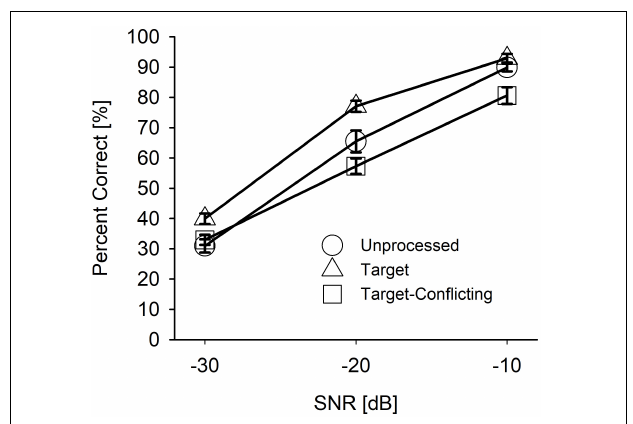
FIGURE 4 | Mean percent correct scores with SEs for each signal processing condition as a function of signal-to-noise ratio